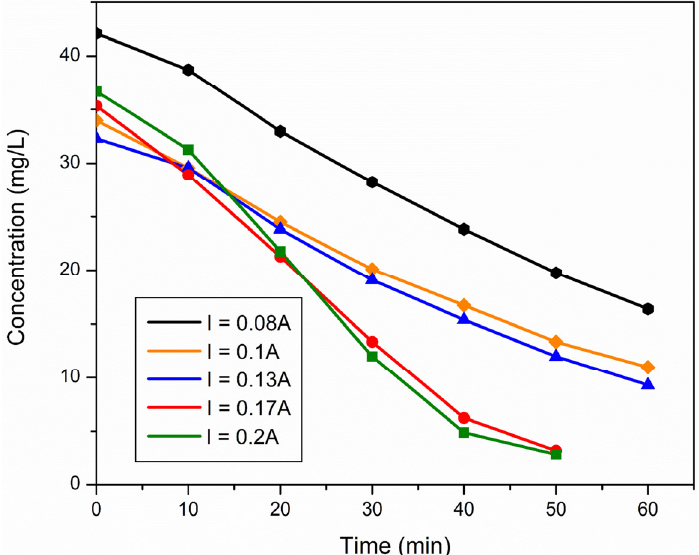
Figure 5. Degradation of RB5 dye under pH 2, 0.15 M of Na 2 SO 4 , and different applied currents.